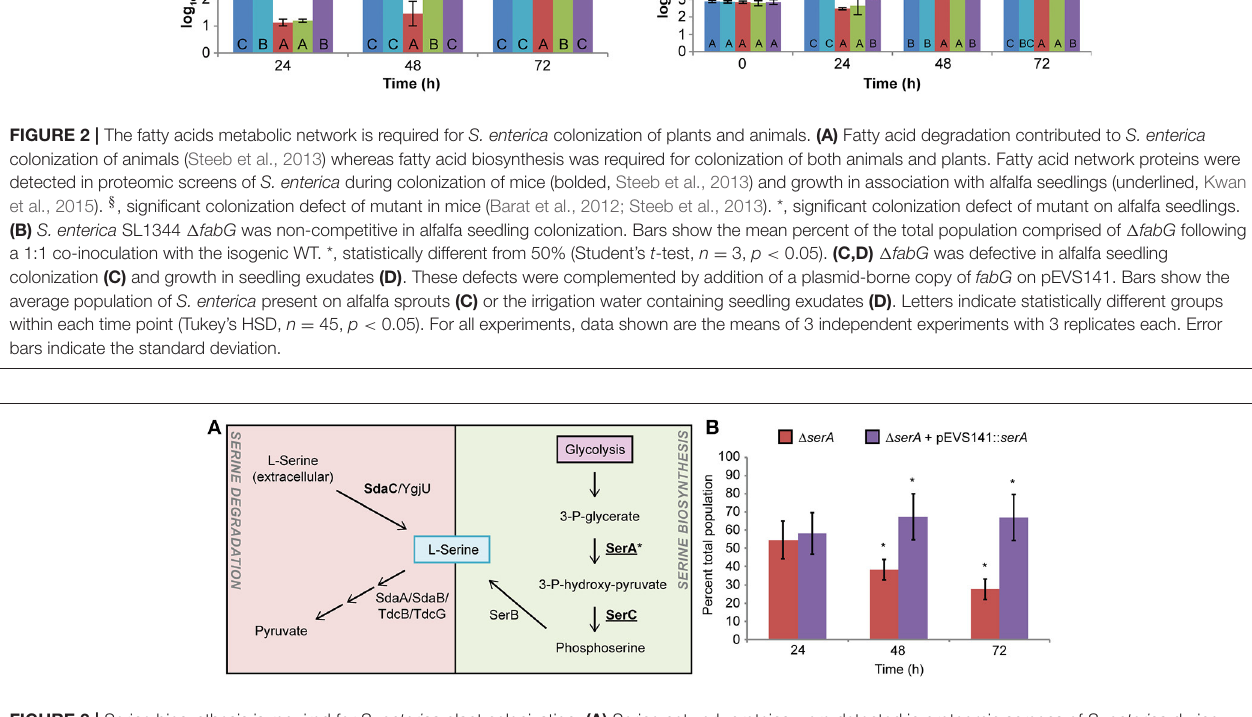
( Figure 4A ). The fitness of the manA mutant was fully restored by addition of 0.2 mM mannose, but not 0.2 mM fructose, suggesting that the directionality of the reaction catalyzed